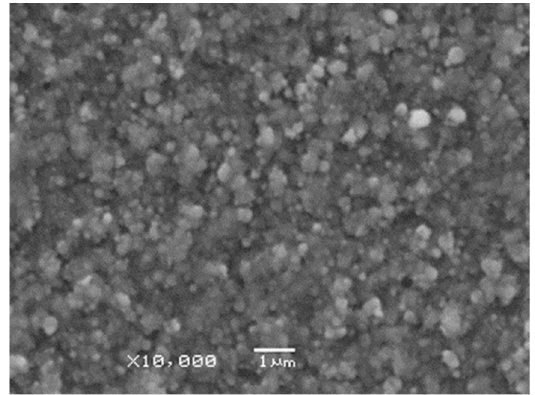
Figure 5. A low magnification SEM micrograph taken on a Cu film deposited by 10,000 pulses focused onto 0.085 mm 2 area on the target surface.